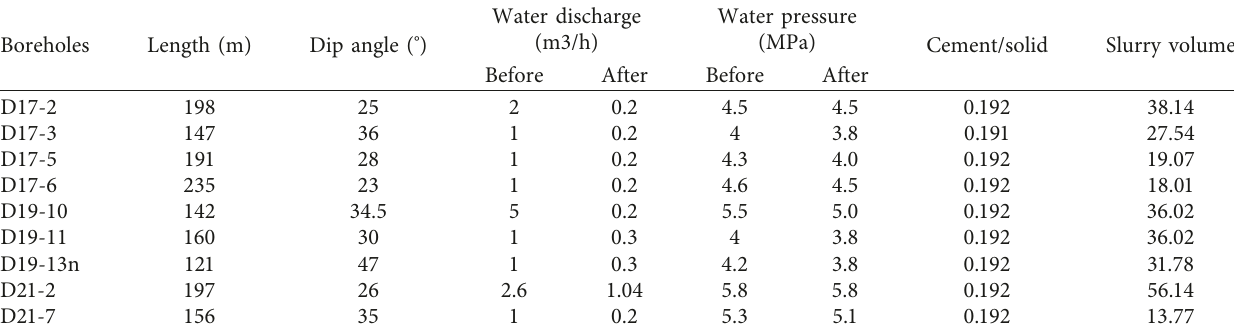
Figure 10: Prediction of filling effect in a single fracture: (a) before grouting and (b) after grouting. Table 1: Slurry volume, water-solid ratio, and basic parameters of typical